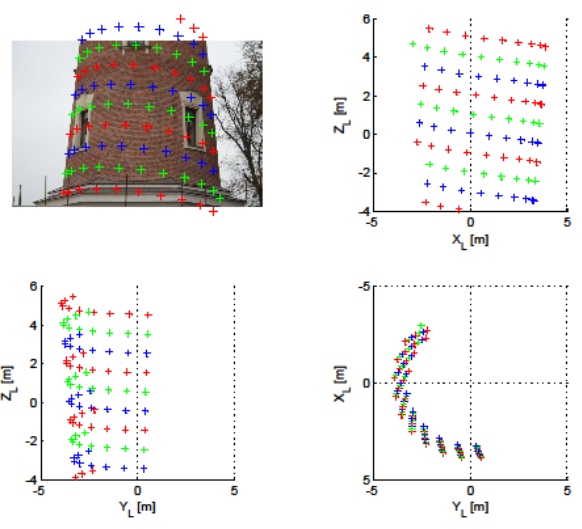
Figure 9. Inverse mapping process shown using points in a grid